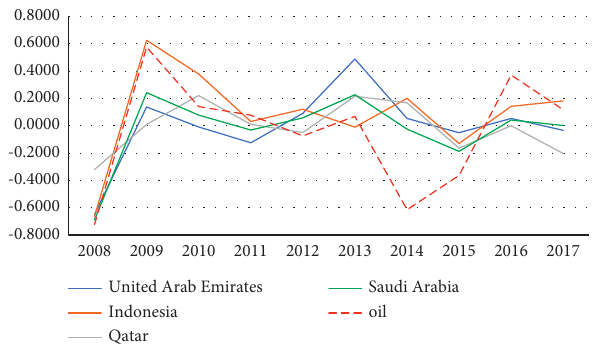
Figure 6: Volatility in oil prices and stock indicator in major crude oil-exporting markets in Asia.